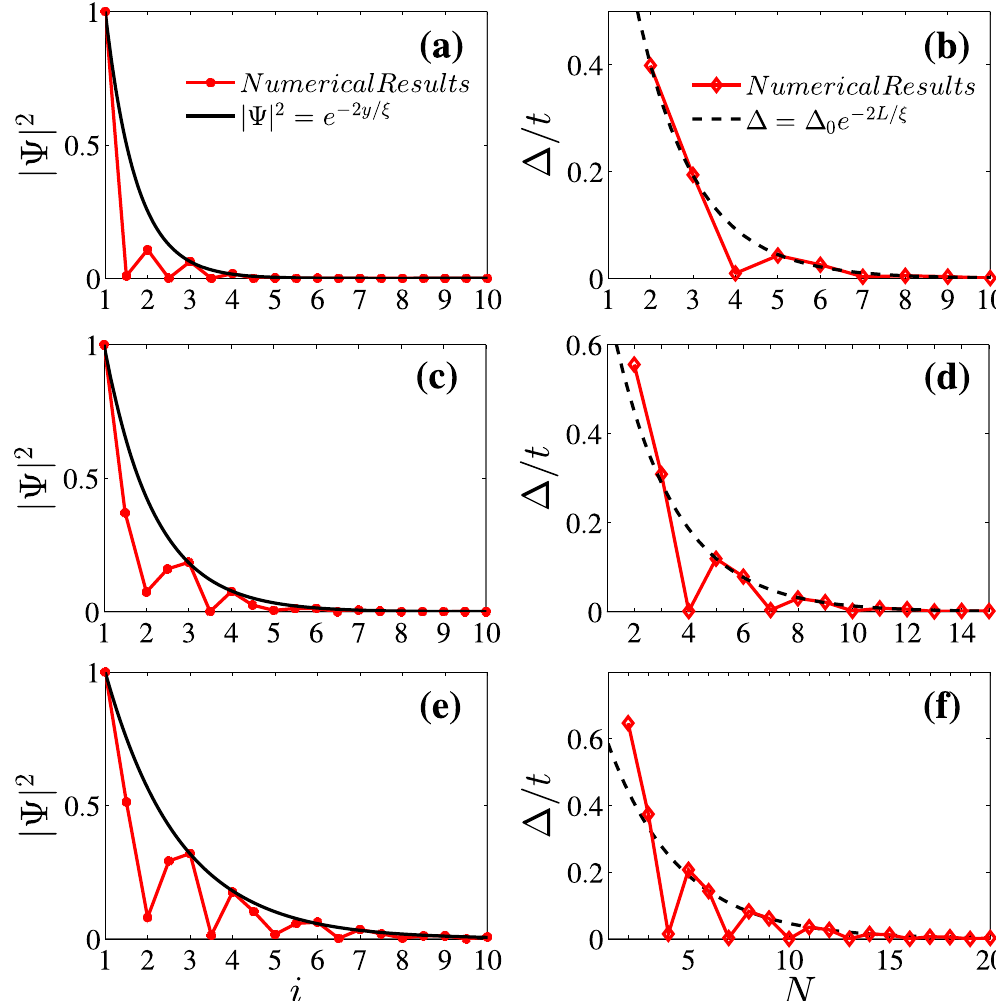
Figure 3. The exact numerical results of the decay of the particle density (left panels) for QSH edge states and the gap of the chiral ribbon with finite width N (right panels) are fitted by the formula,respectively. ( a ) and ( b ) are for the ribbon (3,1), ( c ) and ( d ) are for the ribbon (2,1), and ( e ) and ( f ) are for the ribbon (3,2). The strength of SOC is set to λ = 0.1 t . The Fermi energy is set to E F =